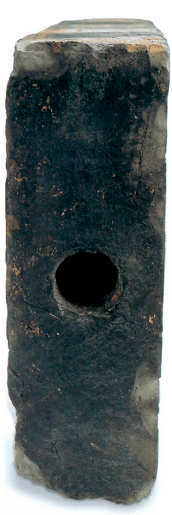
Figure 4. A scroll of the Kara ṇḍ amudr ā S ū tra . 975 CE, Wuyue (907–978). Xylograph; ink on paper. H. 7.6 cm; L. 210 cm. Found in the ruins of the Leifengta, Hangzhou, Zhejiang Province, China. Zhejiang Provincial Museum. After (Li 2009b, p. 45).